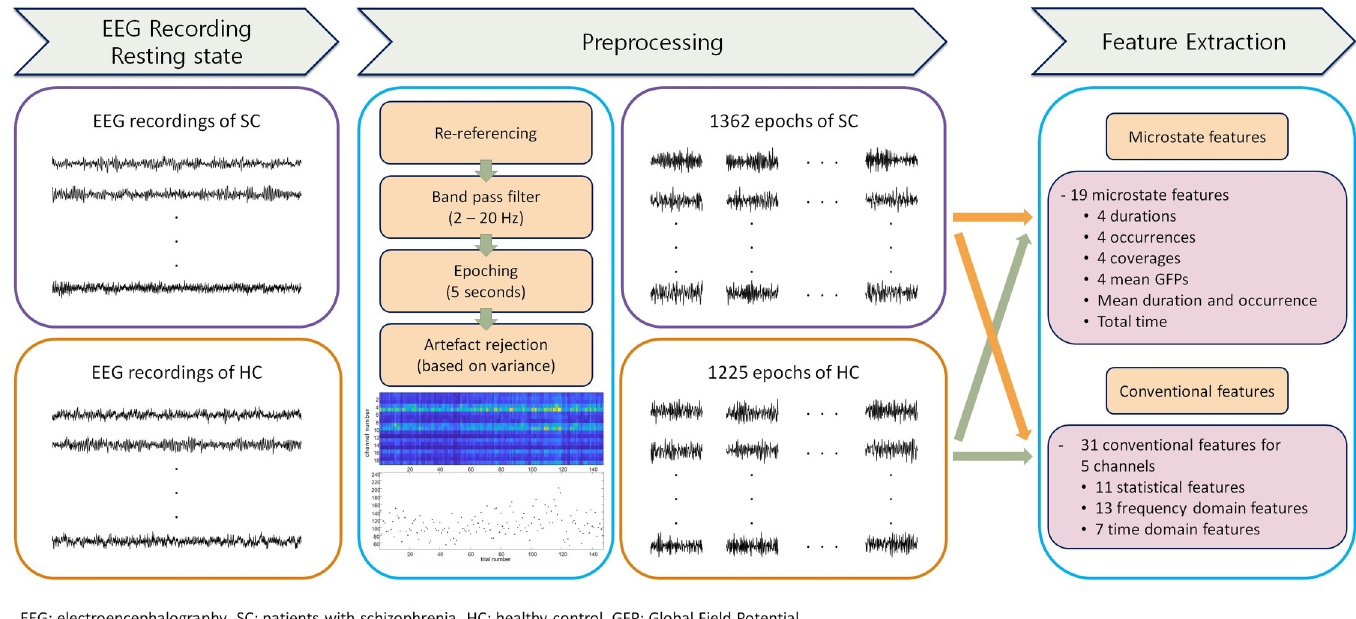
Fig 1. Overview of the process for extracting microstate and conventional EEG features.